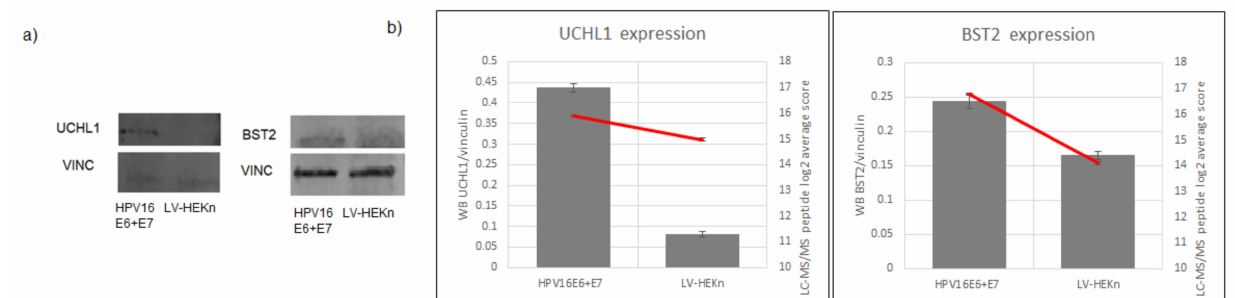
Figure 2. Protein levels in HPV16 E6 + E7 cells and LV-HEKn control cells displayed similar trends in Western blots and LC-MS/MS experiments. ( a ) Western blots of UCHL1 and BST2 in HPV16 E6 + E7 cells and LV-HEKn control cells. ( b ) The grey bars represent the abundance of protein measured by Western blot relative to the abundance of load control protein. The red line represents the LC-MS/MS measurements in the two cell lines. Bar charts indicate the average of three replicates of each cell line.